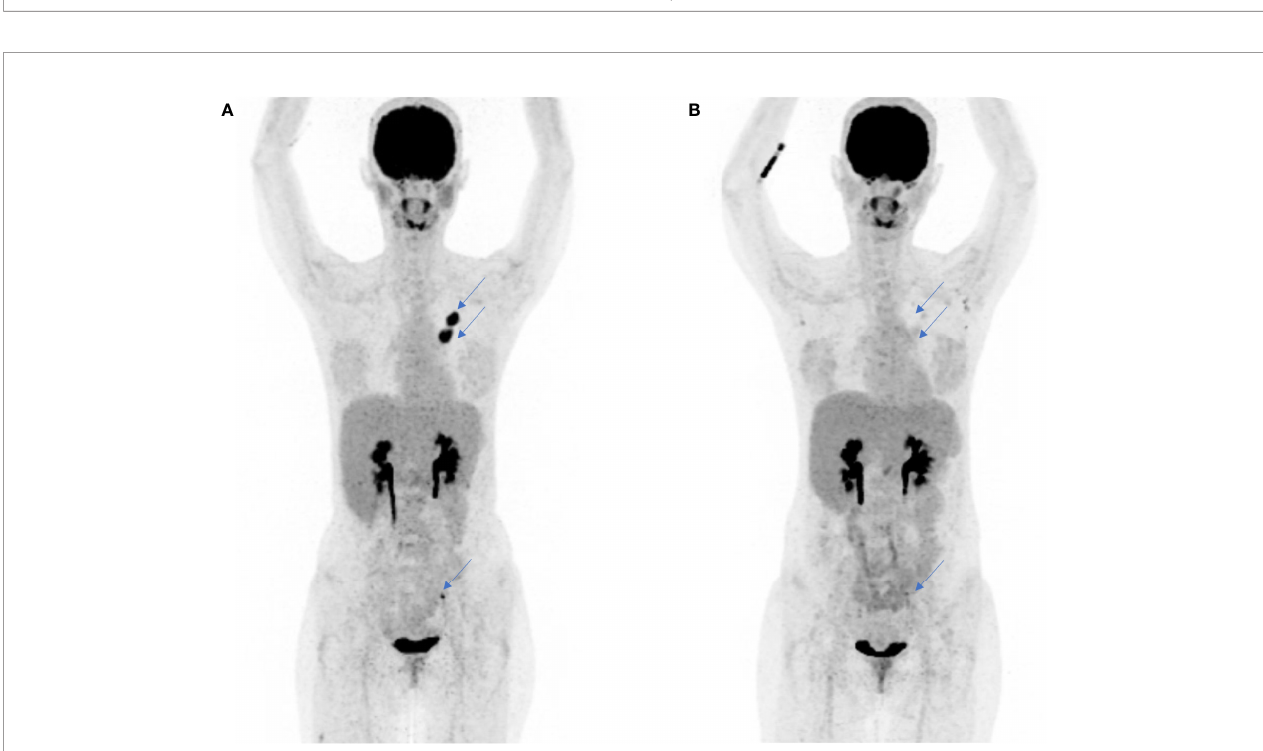
FIGURE 4 | Complete metabolic and subtotal morphologic response to molecularly targeted treatment with alectinib in a 32-year-old patient diagnosed with a metastatic ALK -rearranged LCNEC. (A) FDG-PET scan, whole-body overview, before initiation of fi rst-line treatment with alectinib. No metabolic or morphological response had been observed after one cycle of platin-based chemotherapy administered before obtaining the results of tumor molecular pro fi ling showing ALK rearrangement. (B) FDG-PET scan performed 8 weeks after treatment start with alectinib showing complete metabolic and subtotal morphological response of the primary tumor and the lymph node metastases (blue